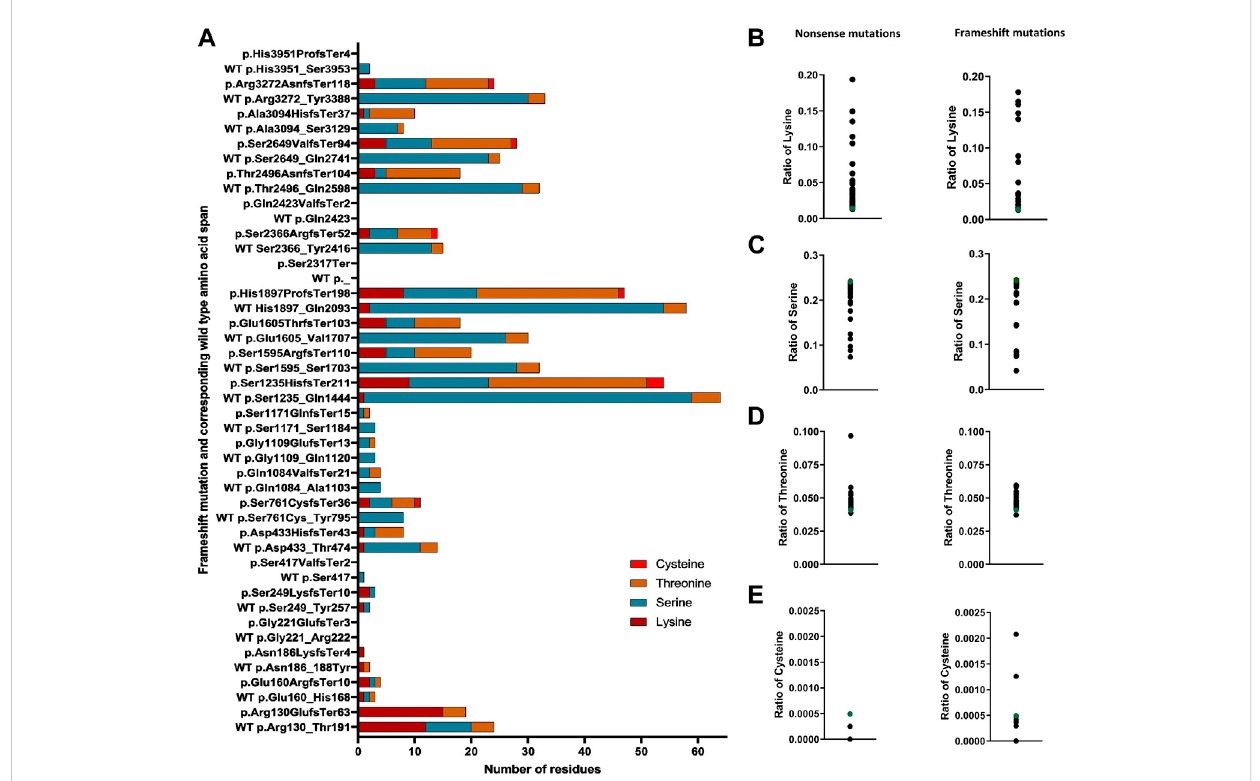
FIGURE 5 Altered content of ubiquitin-conjugating residues in FLG mutation products. (A) Number of ubiquitin-conjugating residues in the frameshift products in comparison to the corresponding wild-type same length span. (B) Ratio of lysine in the nonsense and frameshift mutant protein. (C) Ratio of serine(Ser)inthenonsenseandframeshiftmutantprotein. (D) Ratioofthreonine(Thr)inthenonsenseandframeshiftmutantprotein. (E) Ratioofcysteine in the nonsense and frameshift mutant